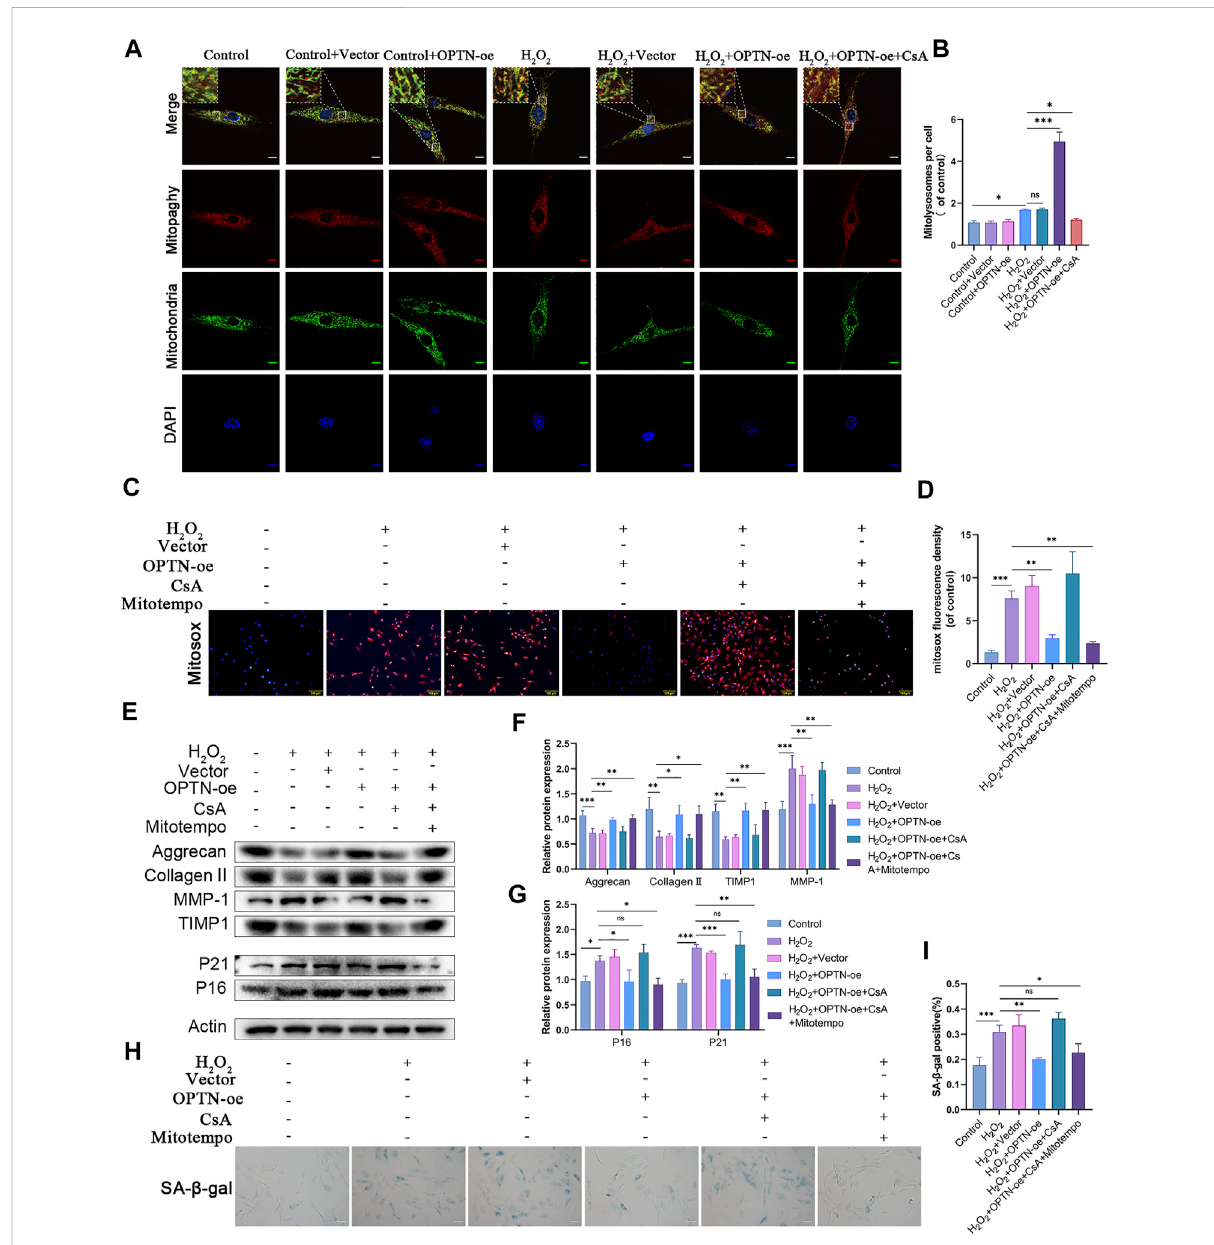
FIGURE 5 OPTN attenuated mtROS through activation of mitophagy and thus reduced senescence and ECM degradation in NPCs. (A – B) MITO-QC was used to detect mitolysosomes inrat NPCs and quanti fi cation (scale bar: 10 μ m). NPCs were treated with or withoutH 2 O 2 conditions in thepresence of CCCP, CsA, and OPTN lentivirus transfection. (C – D) MitoSOX staining was used to detect mtROS in rat NPCs (scale bar: 100 μ m). (E – G) Western blotand quanti fi cation ofAggrecan,MMP-1, Collagen Ⅱ , TIMP1, P21, P16 inrat NPCs.NPCs were treatedwith or without H 2 O 2 conditions inthe presence of mitoTEMPO, CsA. (H – I) Sa- β -gal staining and quanti fi cation (scale bar: 50 μ m). All experiments were performed as means ± SD of 3 times in duplicates. ( n = 10). * p < 0.05, ** p < 0.01, *** p < 0.001, ns p >